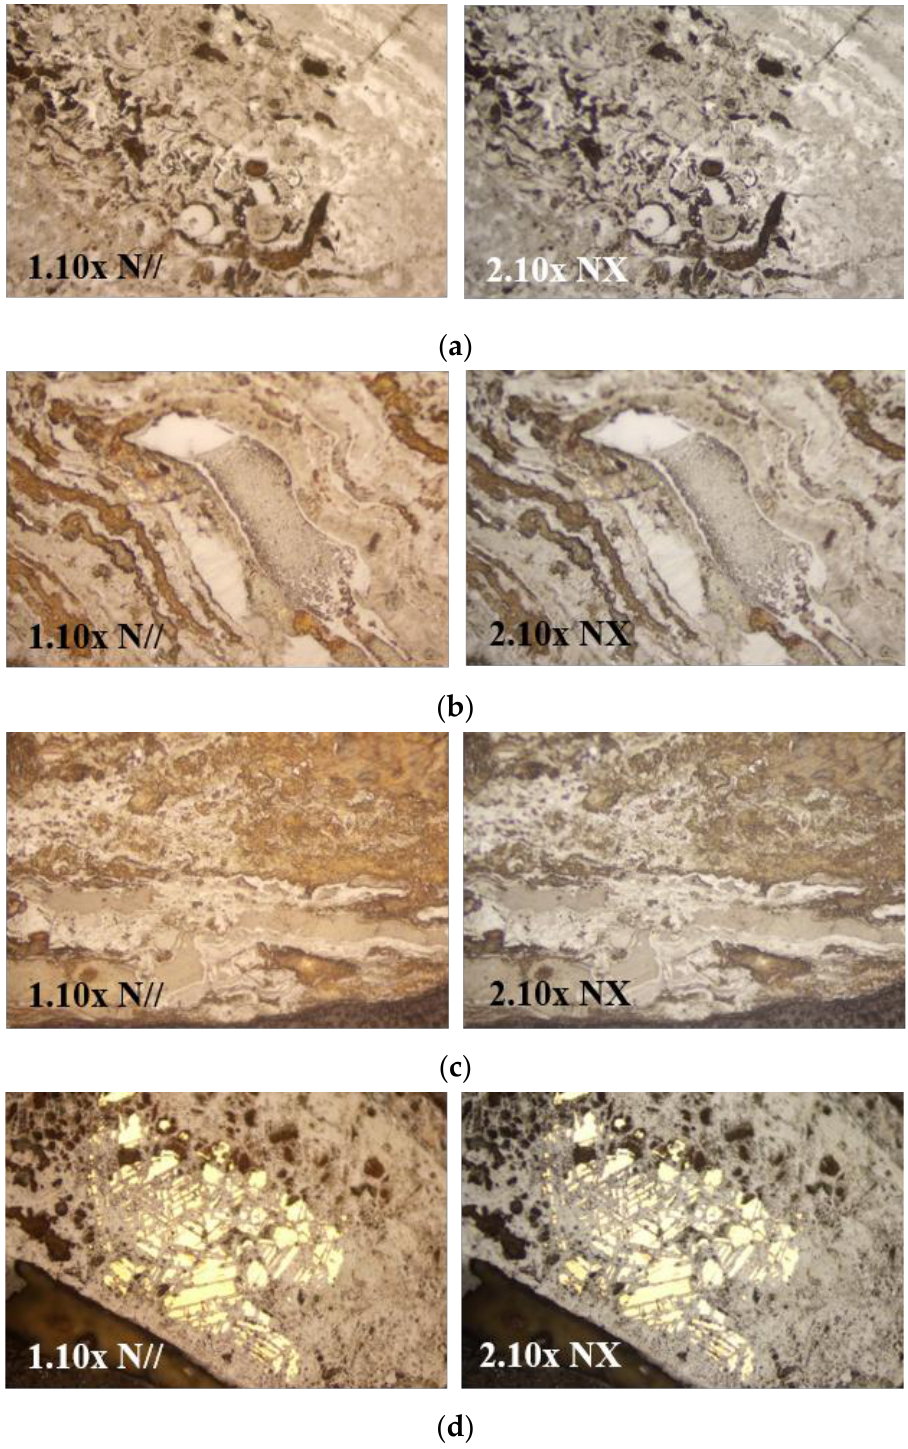
Figure 4. Images obtained by the optical transmitted light polarized microscopy at magnification 10x: ( a ) iron sample n. 8 (1. Nicol X, 2. Nicol//); ( b ) iron sample n. 10 (1. Nicol X, 2. Nicol//); ( c ) iron sample n. 32 (1. Nicol X, 2. Nicol//); ( d ) bronze sample n. 3 (1. Nicol X, 2. Nicol//).